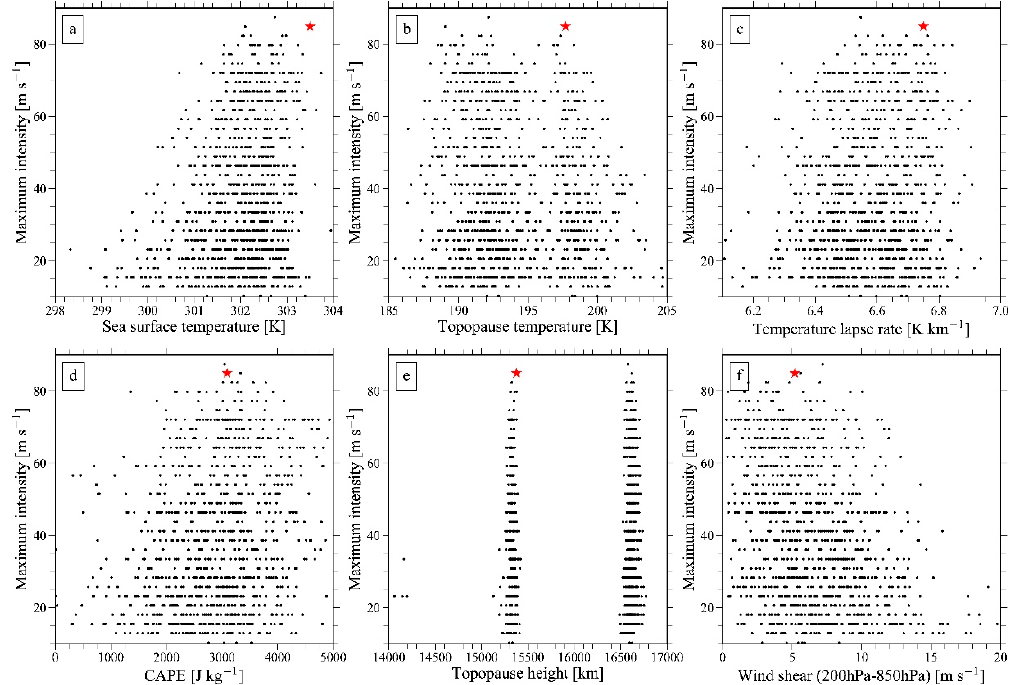
Figure 1. Maximum intensity of tropical cyclones (TCs) in the western North Pacific and their environmental conditions. Environmental variables are ( a ) sea surface temperature, ( b ) tropopause temperature, ( c ) temperature lapse rate in the troposphere, ( d ) convective available potential energy (CAPE), ( e ) tropopause height, and ( f ) vertical wind shear in the 200–850 hPa layer at the time when each TC started the maximum rate of intensification for 24 h. The black dots represent data for the 1068 TCs that were generated in the western North Pacific during the period from 1979 to 2014, and the red star indicates the values of Typhoon Vera (1959).